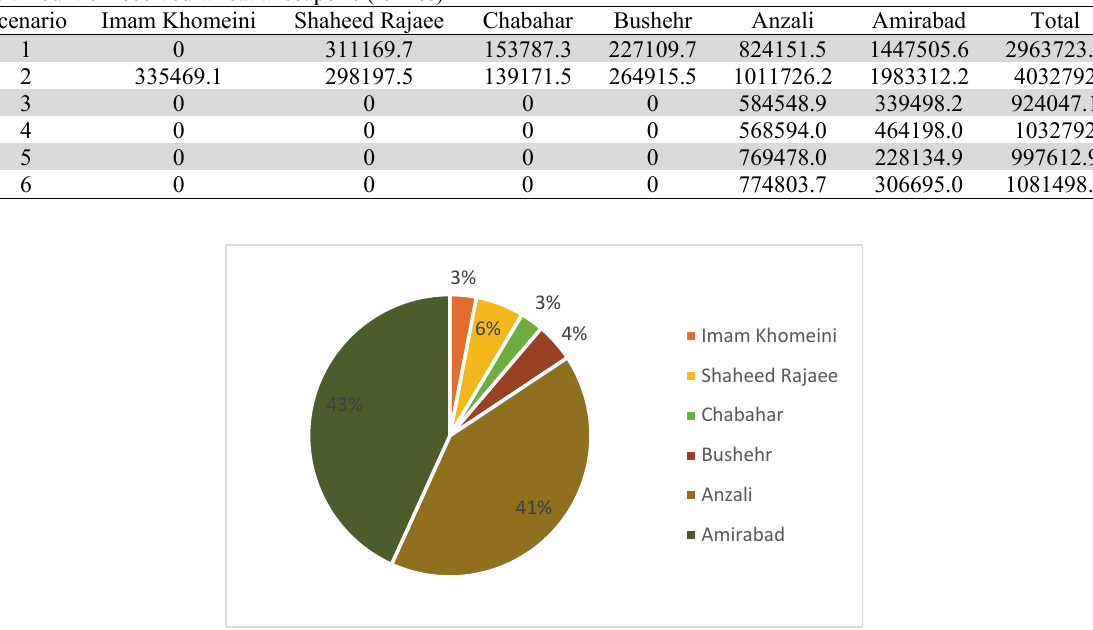
Fig. 1. The share of seaports in importing